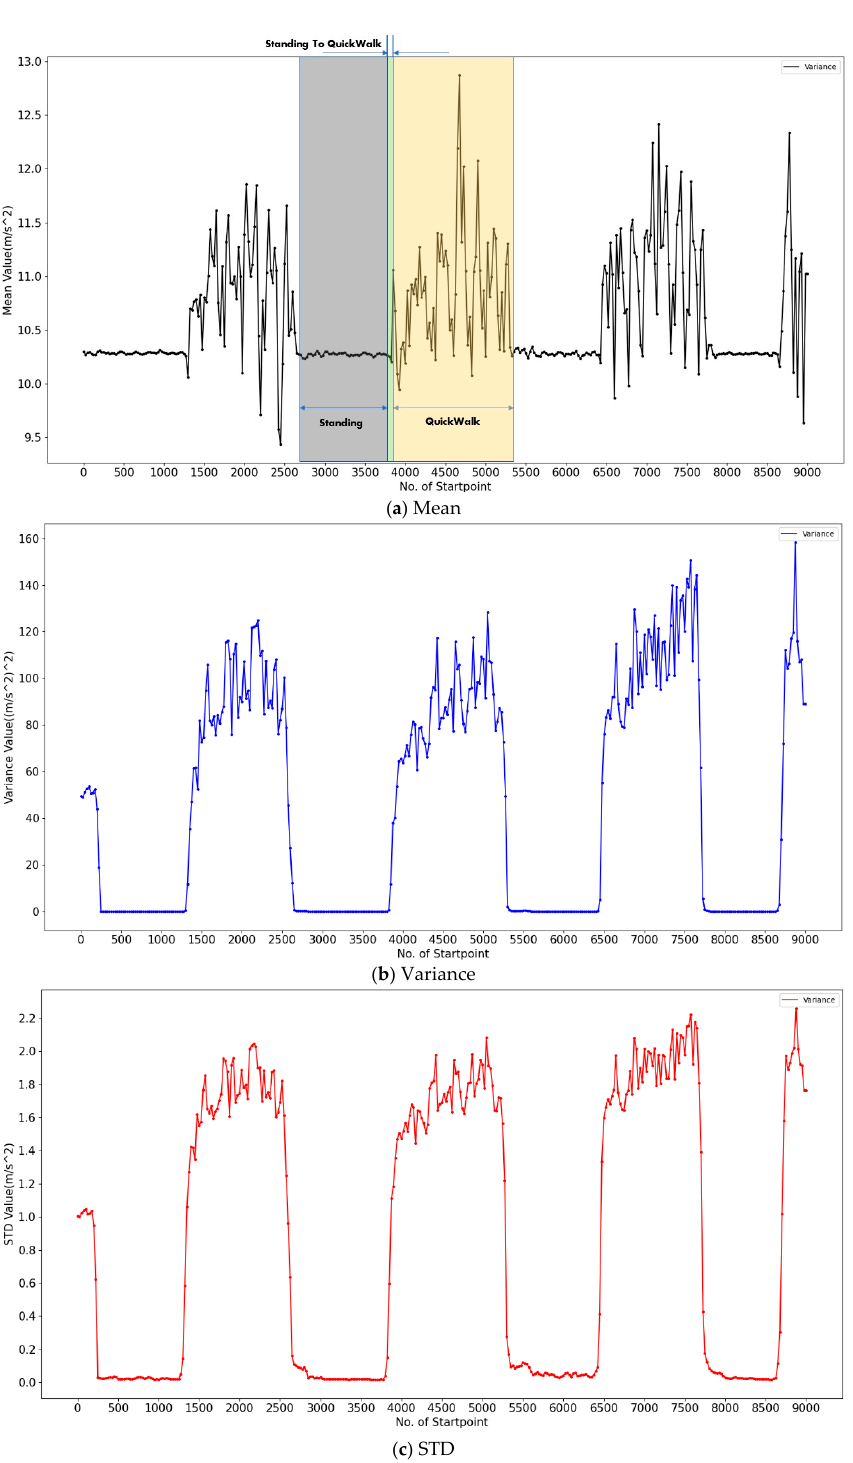
Figure 3. Mean, variance and STD of